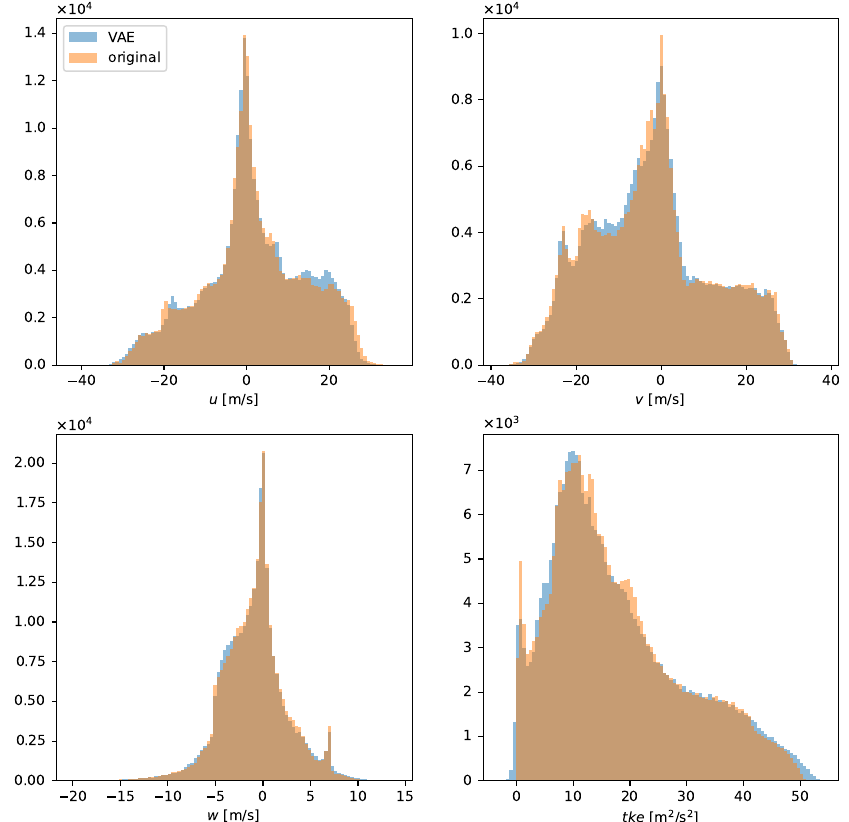
Figure 8. Histogram of the velocity components u , v , w , and TKE of the original and VAE recon- structed